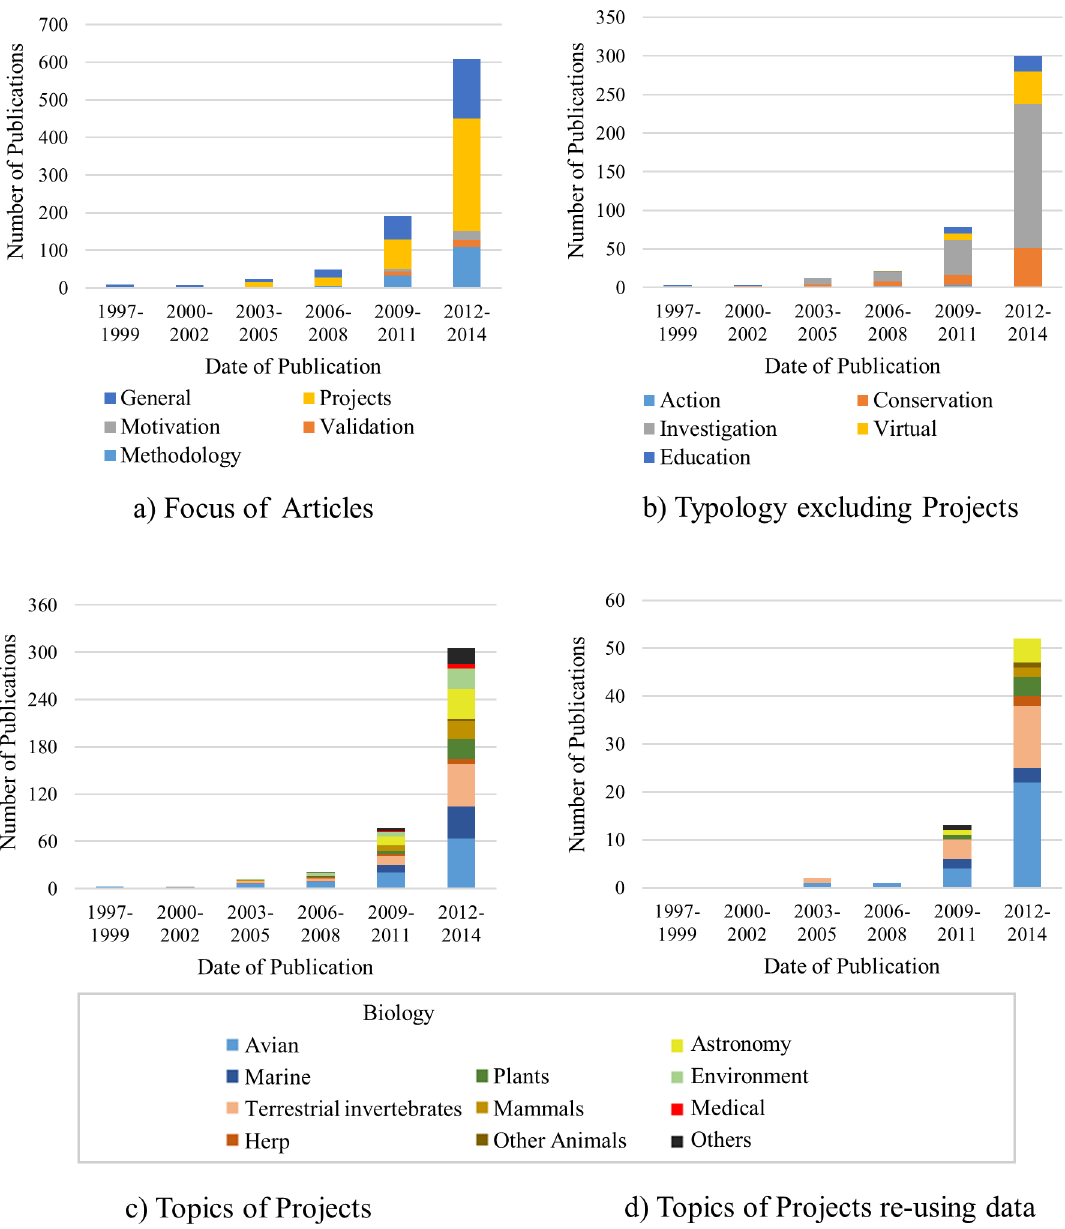
Fig 4. Graphical View of changes in classifications of published articles from 1997 to